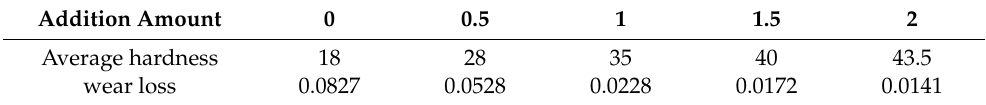
Table 7. Hardness and wear of surfacing layer under different boron additions.